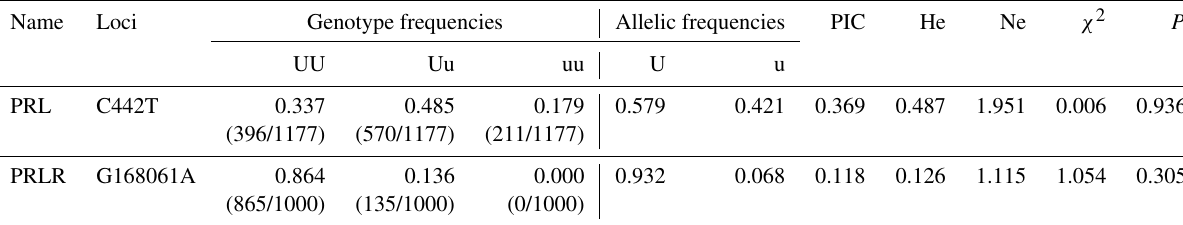
Table A2. Analysis of genetic characteristics of polymorphism on PRL gene and PRLR gene.